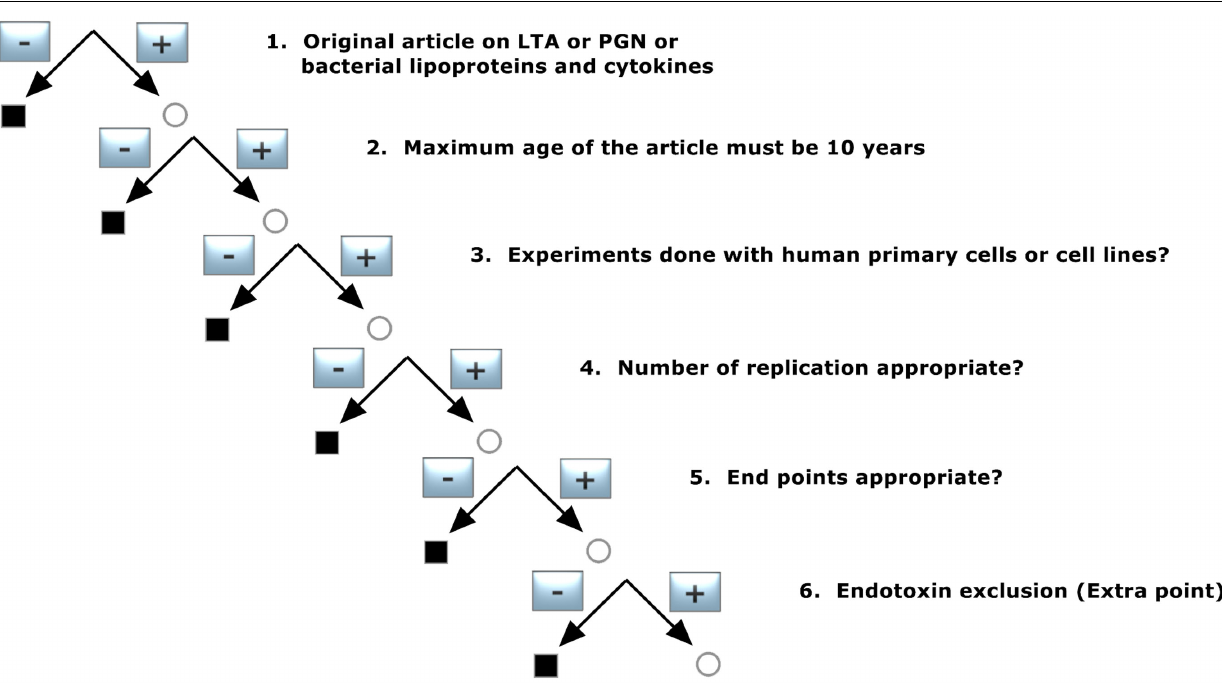
FIGURE 3 | Decision tree 3 (pre-selection of the literature for Koch–Dale criteria 3 and 4).